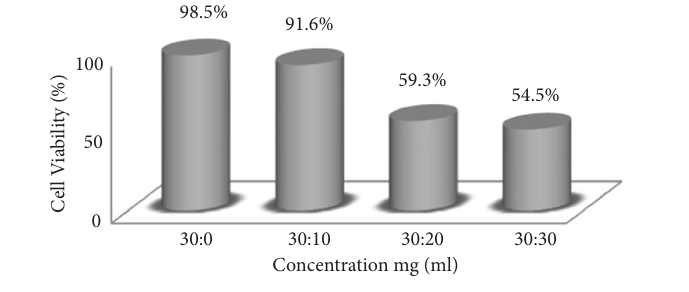
Figure 4: Cytotoxicity test results. Table 2: In vivo test of